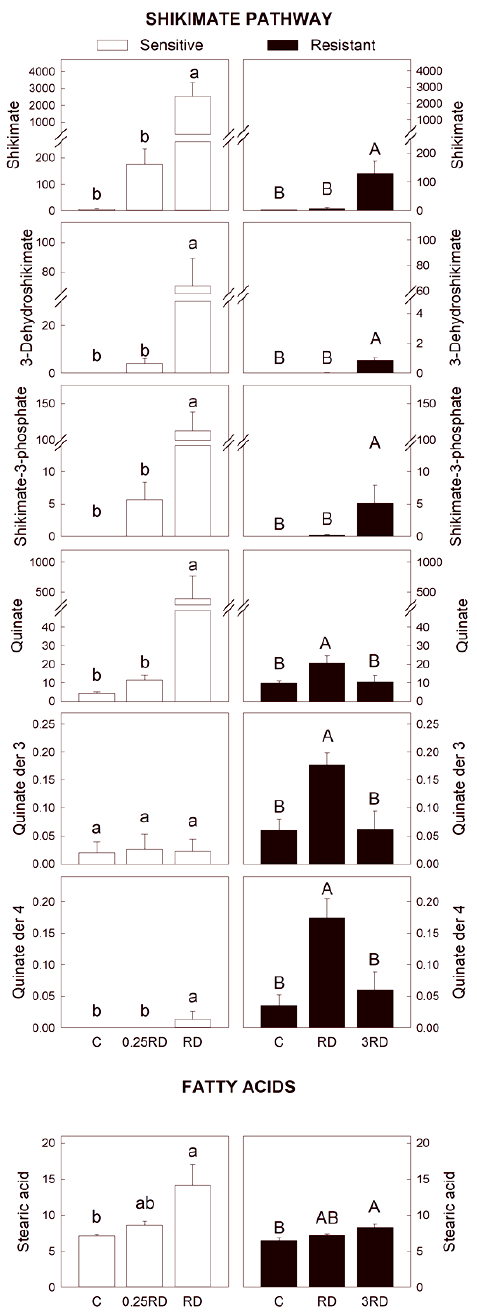
Figure 4. Selected primary metabolites detected by GC–MS in glyphosate-sensitive (GS) and resistant (GR) Amaranthus palmeri plants. Y-axis: normalized peak intensity: metabolites of the shikimate pathway and fatty acids. Plants were not treated (control, C) or treated with glyphosate at two doses. The GS population was treated with 0.25 or 1 the field recommended dose (RD); the GR population was treated with 1 and 3 RD; mean ± SE (n = 4–6). Different letters within each population indicate significant differences between treatments ( p -value ≤ 0.05, Tukey).